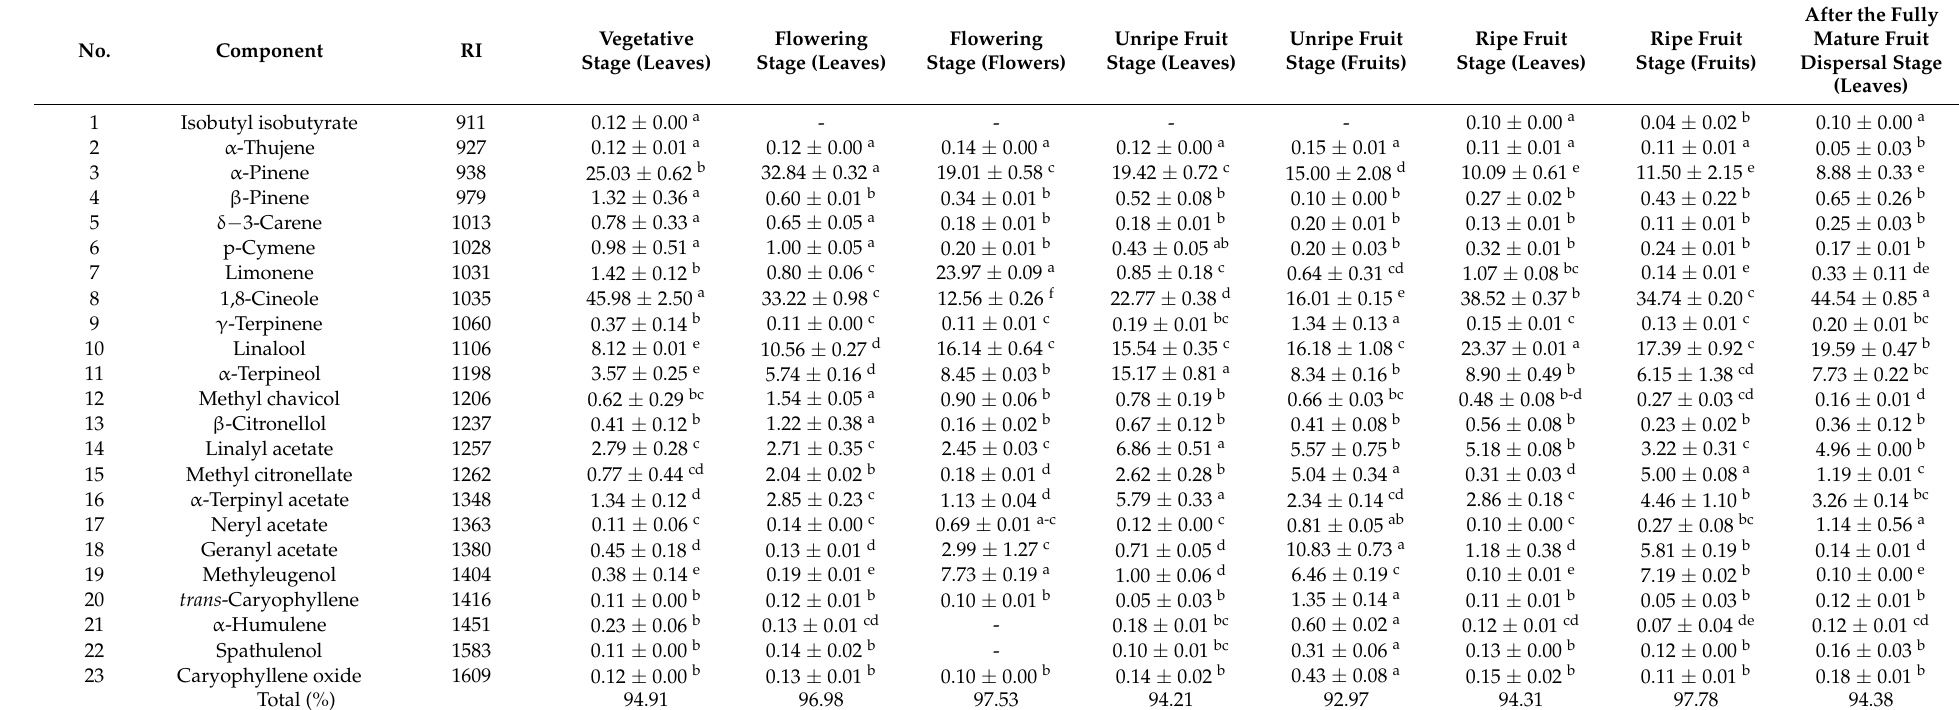
Table 1. EO composition (%) of different myrtle organs in different phenological